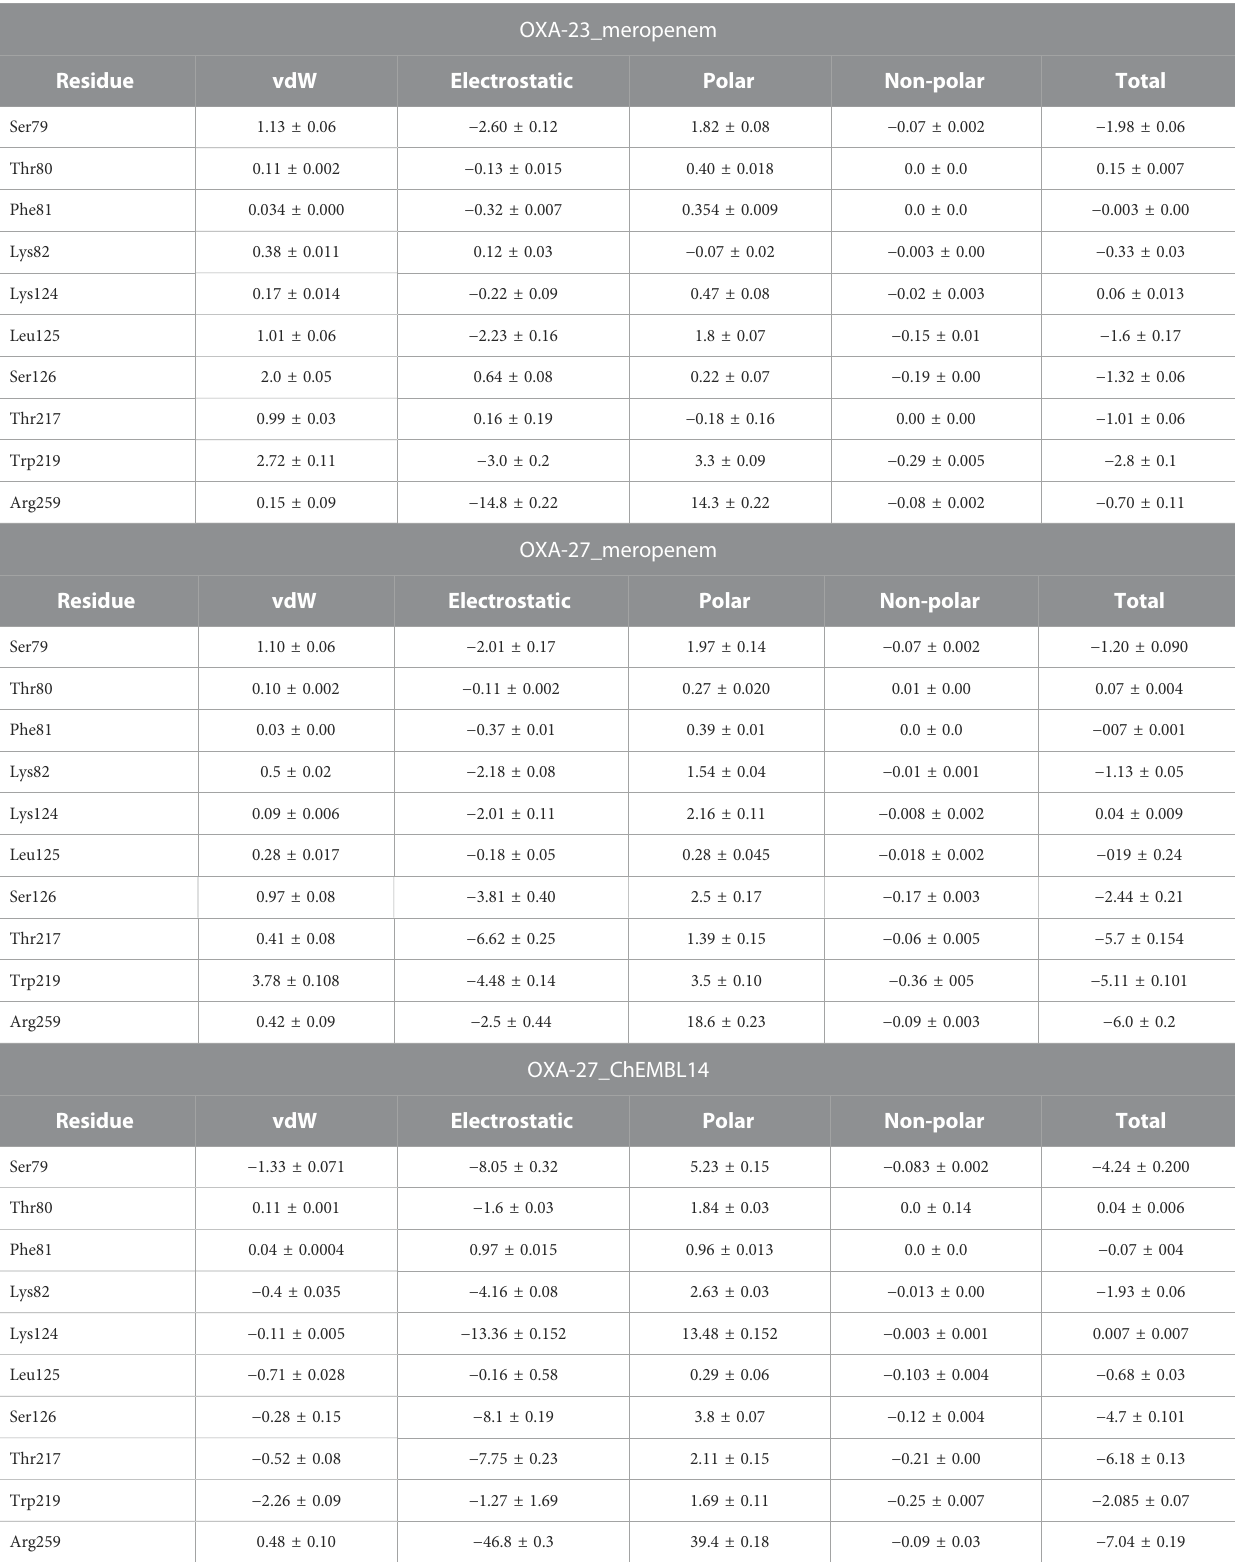
TABLE 2 Binding free energy decomposition of OXA-23 and OXA-27 with meropenem and its